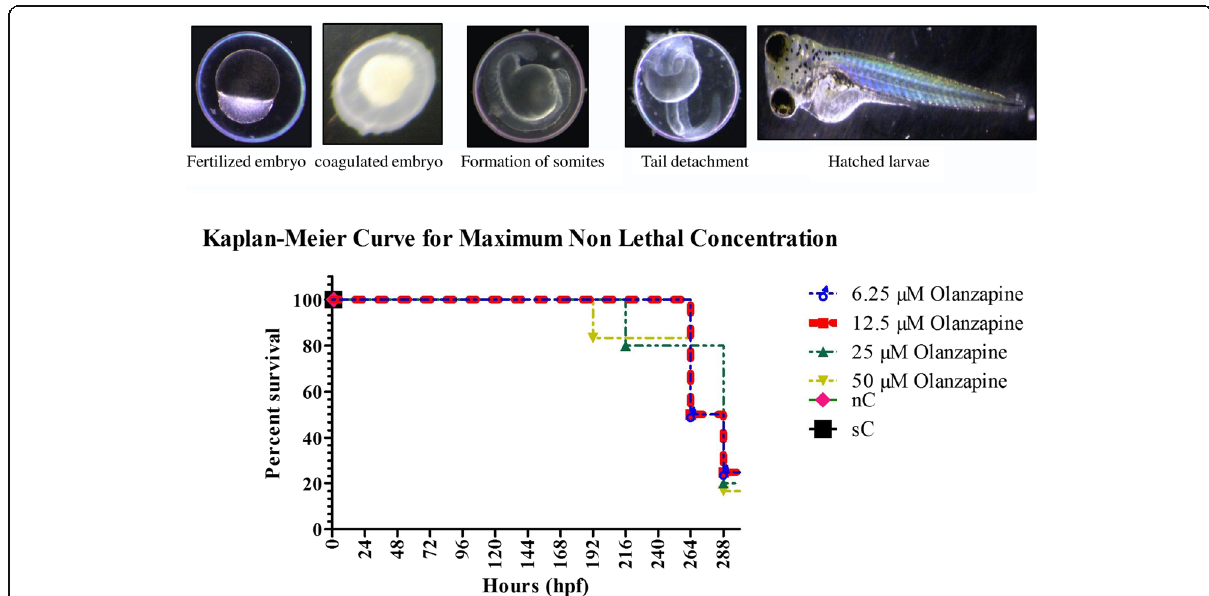
Fig. 3 Survival curve (Kaplan-Meier curve) of larvae exposed to olanzapine. nC, negative control, sC, solvent control. Total number of larvae exposed to each concentration ( n ) =